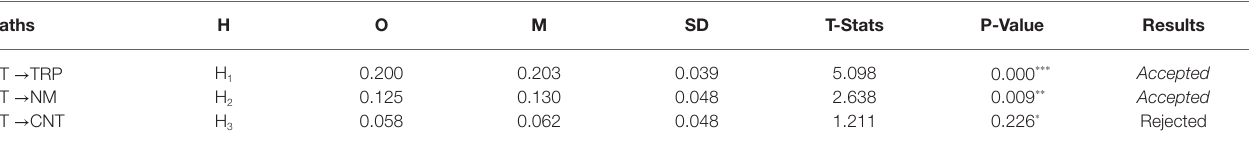
TABLE 5 | Results for structural